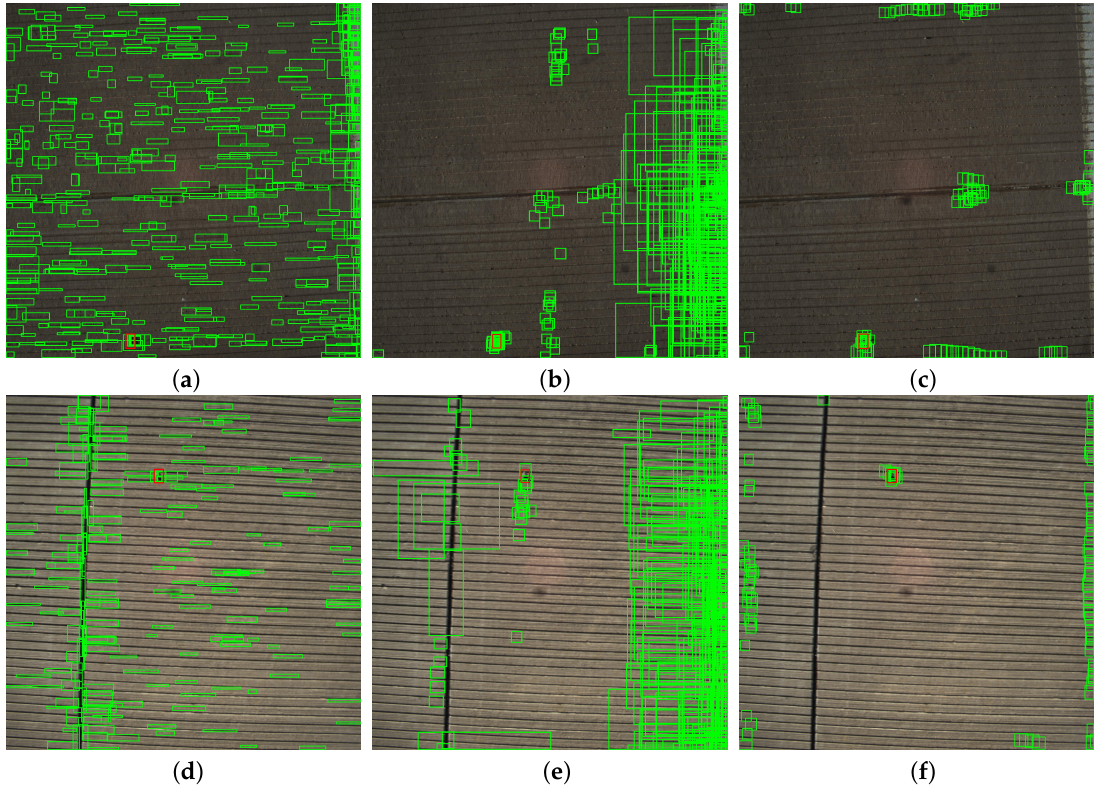
Figure 8. ( a , d ) FOD location results by Selective Search; ( b , e ) results of original RPN; and ( c , f ) results of improved RPN. The green boxes are generated FOD candidates by these two methods respectively, while red boxes are ground